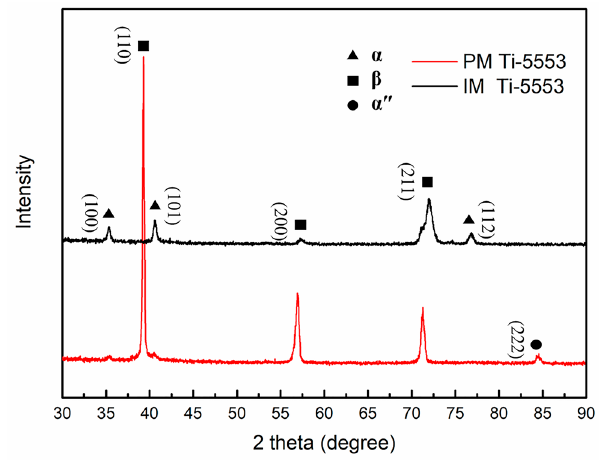
Figure 2. XRD patterns of the as-consolidated PM and the as-cast IM Ti-5553 alloys.